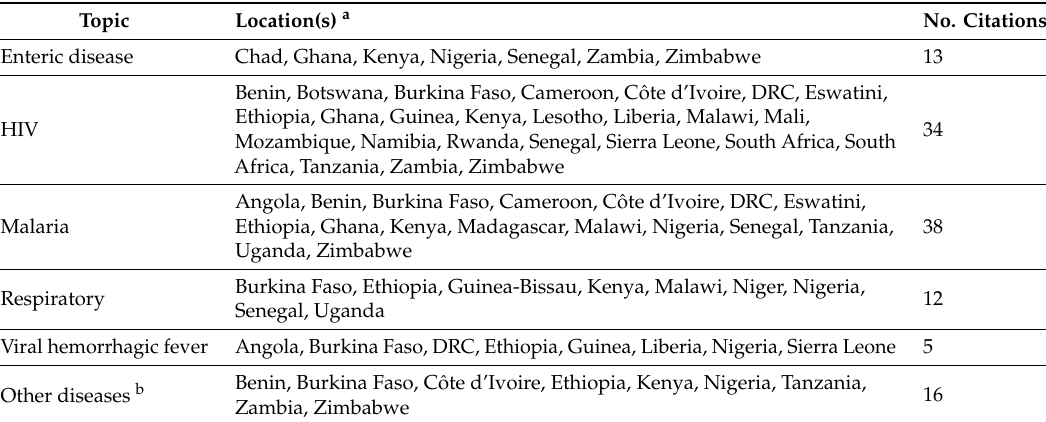
Table 1. Summary of number of studies and their locations per disease group.